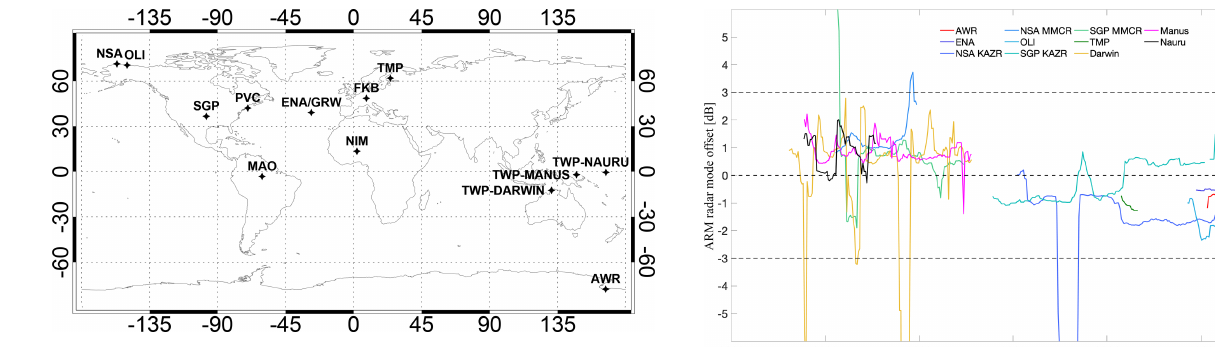
Figure 1. Location of the fixed and mobile ARM profiling cloud radars calibrated using the CloudSat Cloud Profiling Radar.